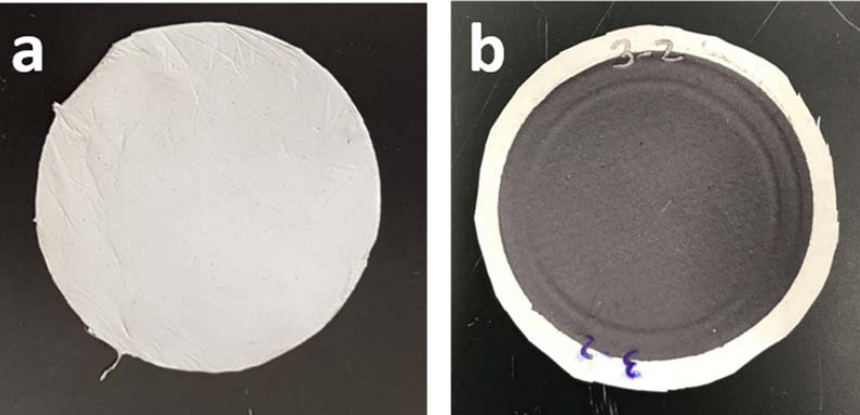
Figure 4. ( a ) neat coPA mat and ( b ) coPA/SL ‐ Ti 3 C 2 T x membrane.